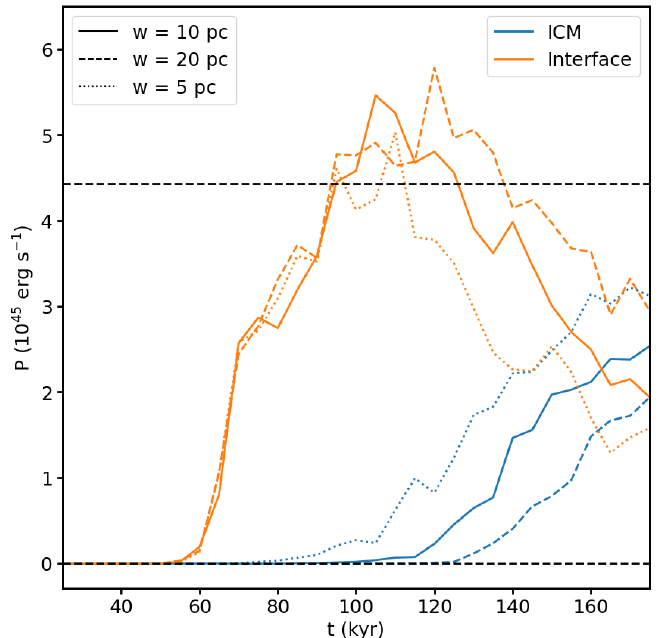
Figure 8. The power in ICM, lobe, interface, and jet components flowing through the surface (shown in the left panels of Figure 6) as a function of time, for the simulations with varying interface widths w